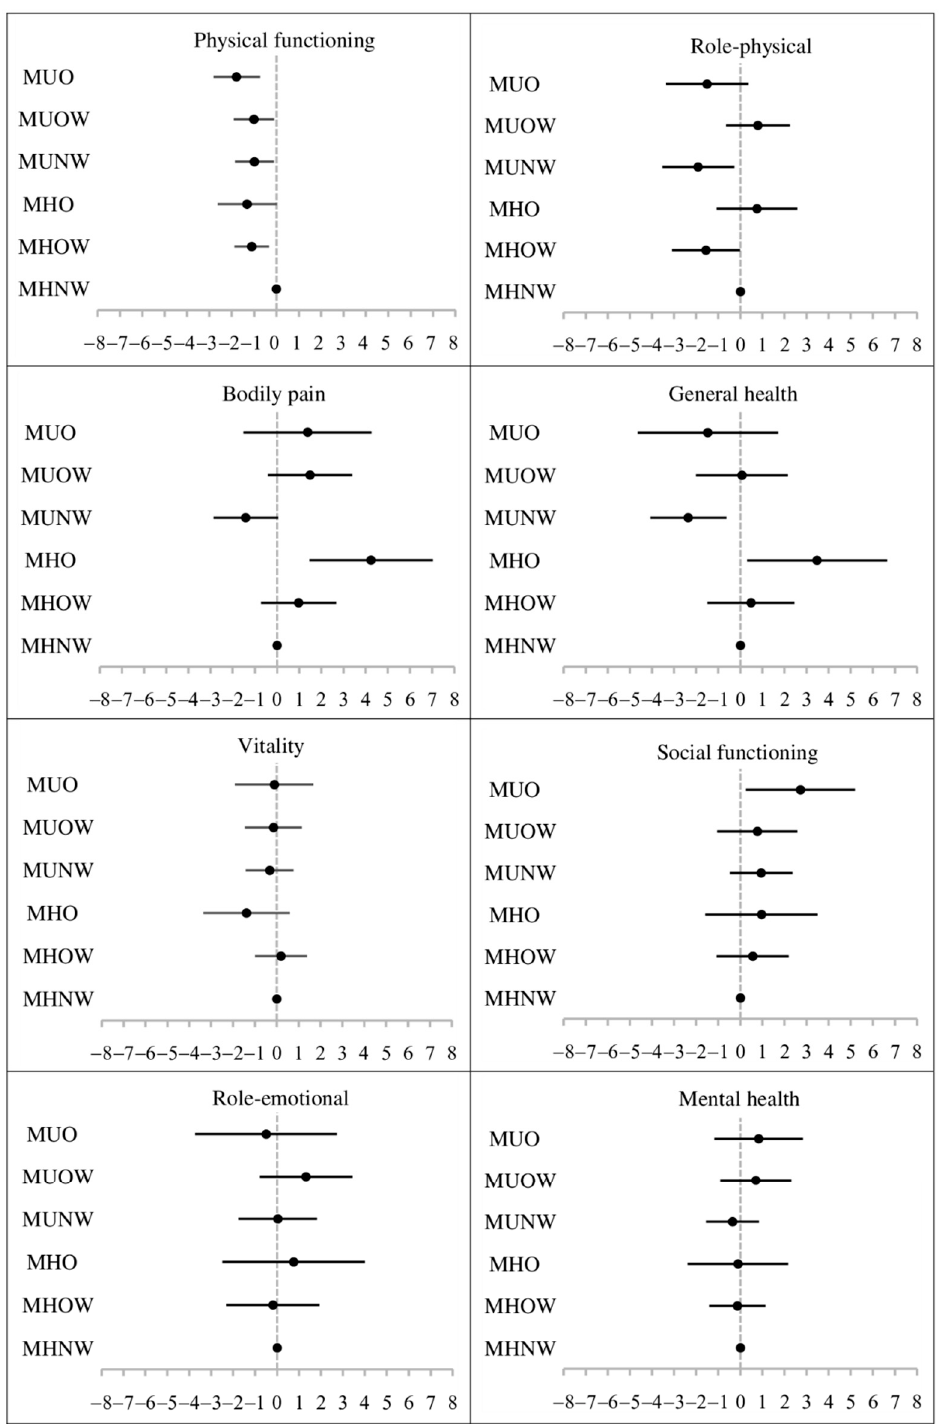
Figure 1. The association between metabolic health/BMI groups and eight domains of SF-36 ( β coefficient and 95% confidence interval). Note. BMI = body mass index; MHNW = metabolically healthy normal weight (reference group); MHOW = metabolically healthy overweight; MHO = metabolically healthy obesity; MUNW = metabolically unhealthy normal weight; MUOW = metabolically unhealthy overweight; MUO = metabolically unhealthy obesity; SF-36 = the 36-Item Short Form Health Survey. The analyses were conducted by generalized linear mixed-effects models with adjustment for age, sex, marital status, level of education, smoking, alcohol consumption, groups of physical activity, and follow-up